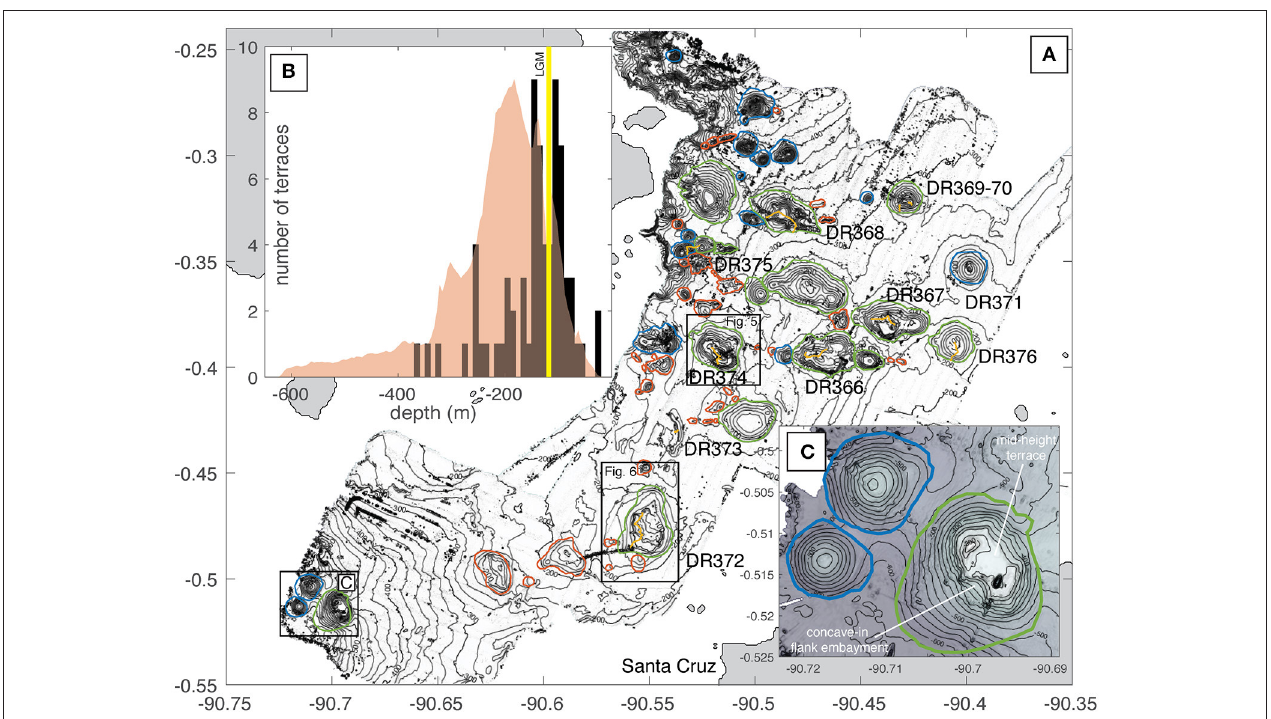
FIGURE 4 | (A) Bathymetric map of the Santiago seamounts. Gray polygons locate islands. Bathymetric contour interval is 20m. Green lines locate seamounts > 100m of relief that have identified terraces. Blue lines locate other mapped seamounts > 100m. Red lines locate mapped seamounts, which are < 100m in relief. Gold lines indicate dive tracks. Locations of inset (C) and Figures 4 , 5 are indicated by black boxes. (B) Black/gray bars are histogram of depths of all identified terraces. Semi-transparent red polygon shows the probability distribution of all depths within the mapped seamount footprints. Yellow bar indicates the depth of the last glacial maximum sea-level lowstand ( Bintanja et al., 2005) (C) Seamount with summit depth ∼ 300m with identified terrace and summit embayment and irregular shaped summit